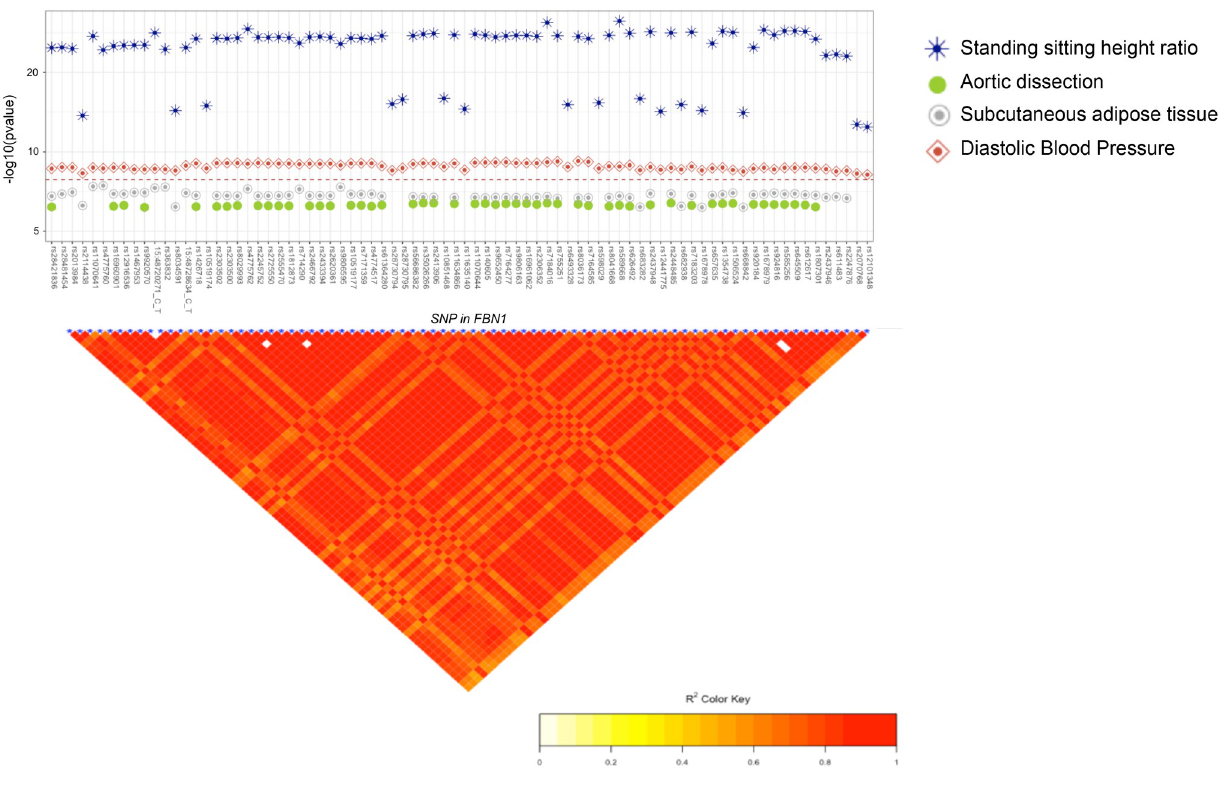
Fig 3. PheWAS result and linkage plot for variants with pleiotropy in FBN1 . Associations between variants associate with multiple phenotypes (a) and linkage between the variants in FBN1 (b). The red line represents the level of significance after Bonferroni correction (p = 2.7x10 -07 ).